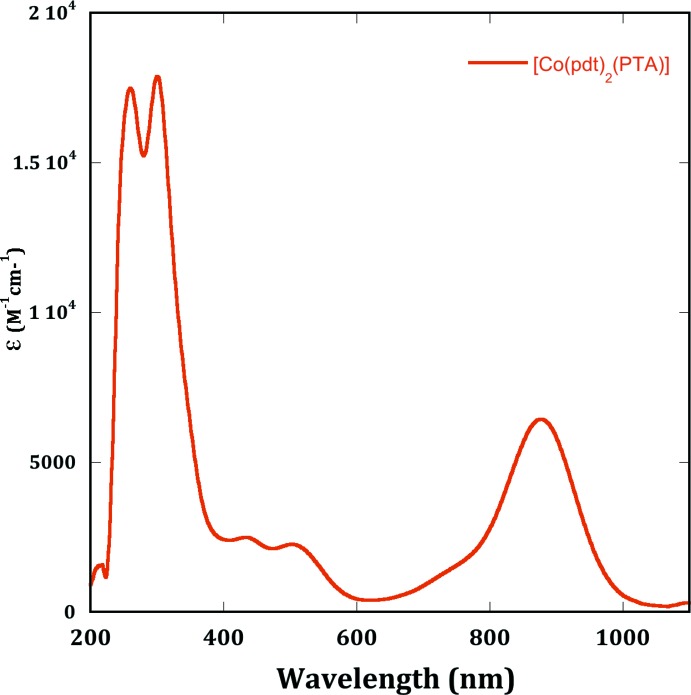
UV–vis spectrum of [Co(pdt)2(PTA)] in di­chloro­methane solution at 25°C.